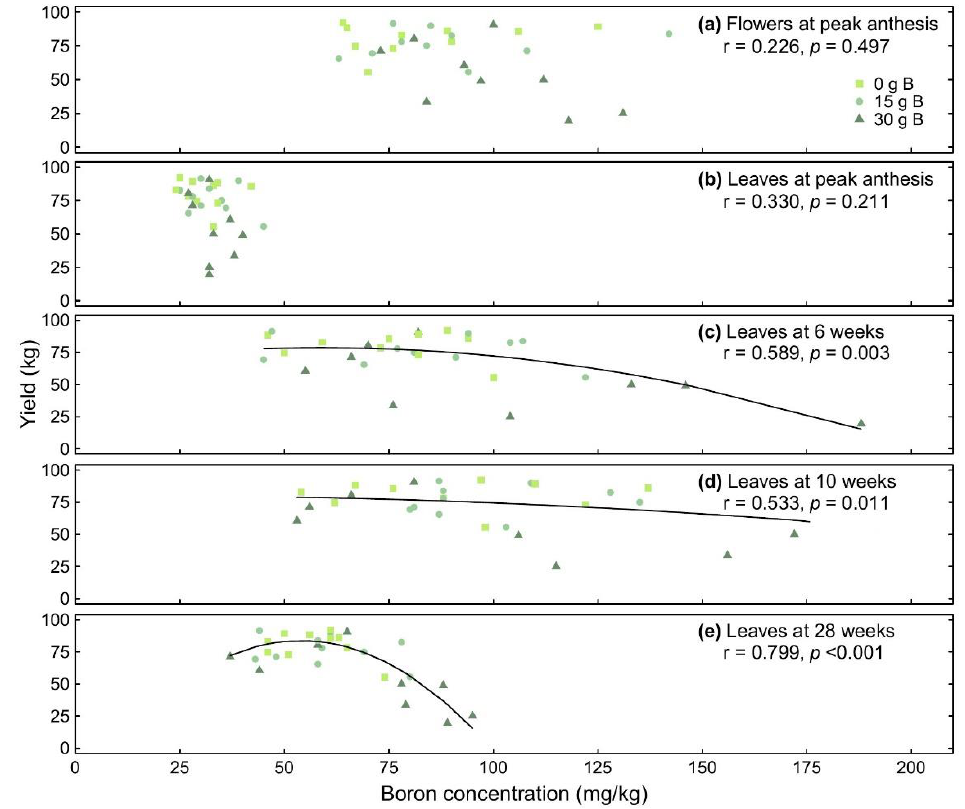
Figure 6. Relationships between final yields of Hass avocado trees treated with 0, 15 or 30 g boron (B) per tree prior to anthesis and boron concentrations of ( a ) flowers at peak anthesis; ( b ) leaves at peak anthesis; ( c ) leaves at 6 weeks after peak anthesis: yield = 65.60 + 0.45[B 6 ] − 3.79 × 10 − 3 [B 6 ] 2 ; ( d ) leaves at 10 weeks after peak anthesis: yield = 80.06 + 0.02[B 10 ] − 7.61 × 10 − 4 [B 10 ] 2 ; ( e ) leaves at 28 weeks after peak anthesis: yield = − 34.28 + 4.38[B 28 ] − 0.04[B 28 ] 2 , where [B 6 ], [B 10 ] and [B 28 ] are the foliar boron concentrations at 6, 10 and 28 weeks after peak anthesis, respectively ( n = 30 trees).